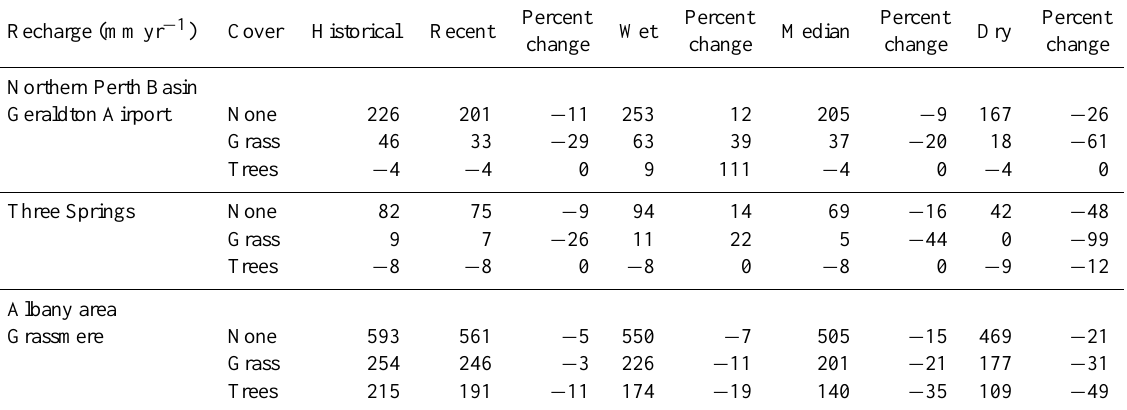
Table 5. Average recharge (mmyr − 1 ) simulated with WAVES model. Recharge rates shown for northern Perth Basin and Albany area climate zones using current and future climates, and percentage departure from modelled values of historical record. Recharge value is rounded off for presentation